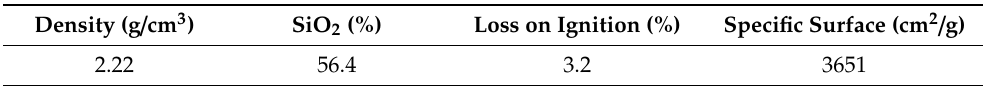
Table 5. Properties of fly ash.